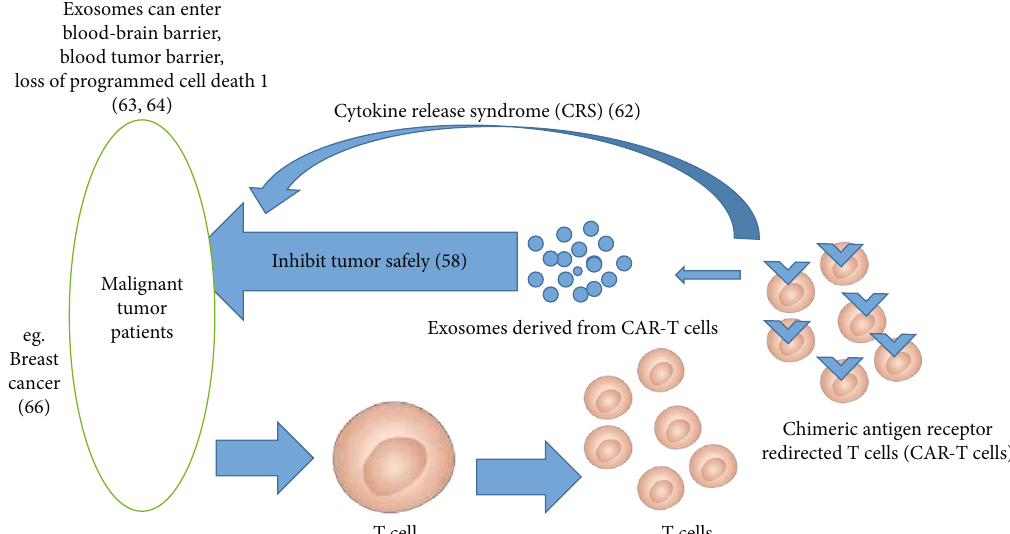
Figure 1: CAR-T cell-derived exosomes for tumor